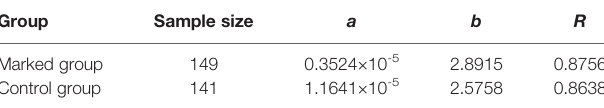
TABLE 1 | Parameter values of the equation ( W = aL b ) fi tted to body length and body weight in Coilia nasus larvae in the marked and control groups. Group Sample